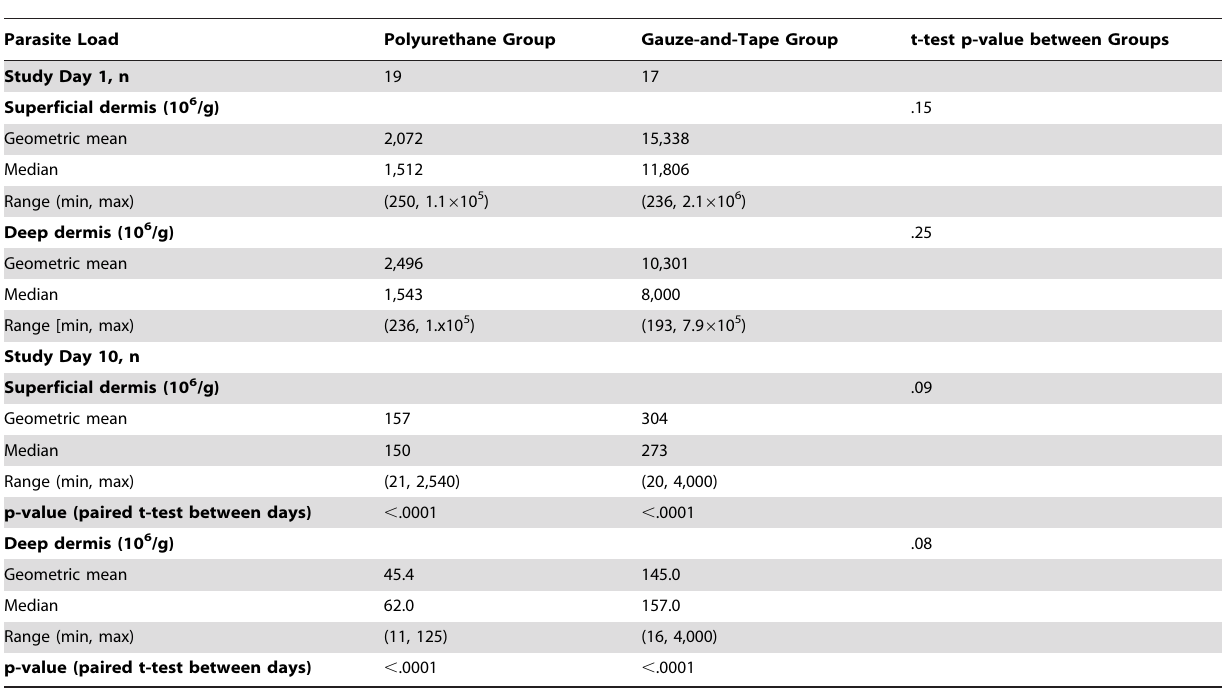
Table 4. Parasite load fold-reduction ratios.